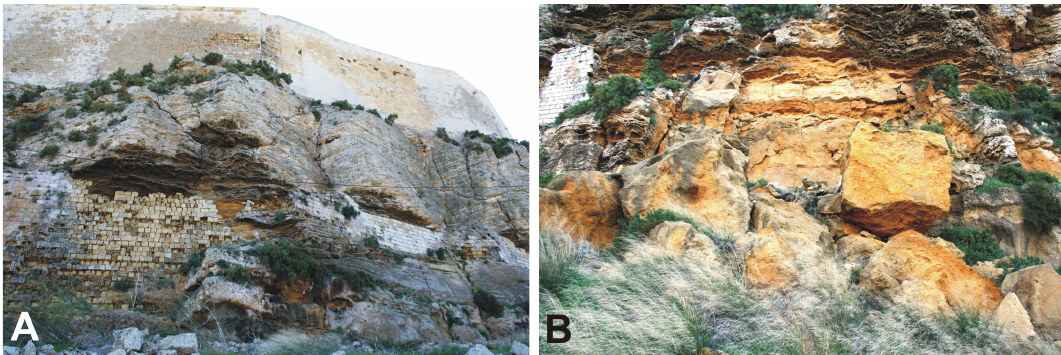
Fig. 5. Instability mechanisms affecting the UCL rock plate underlying Citadel ( A : rock mass and underpinning masonry; B : rock fall debris).